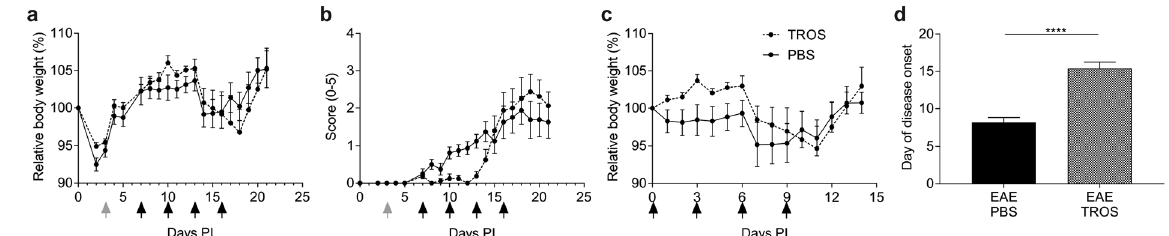
Figure 7. ( a – d ) Local therapeutic treatment with TROS delays EAE development but does not prevent it. hTNFR1 transgenic (Tg) mice were immunized with MOG 35-55 peptide and pertussis toxin to induce EAE. Three days post-immunization (PI), brain cannulas were implanted (grey arrow). When 6/16 of the mice were symptomatic (7 days PI), they were divided in balanced groups. 7.75 µ g/5 µ l TROS (n = 8) or 5 µ l PBS (n = 7) was directly infused through a cannula into the brain ventricles every three days until day 16 PI (black arrow). Mice were weighed and clinically scored daily. (a , b ) Relative body weight (relative to initial body weight) ( a ) and clinical scores (scale 0-5) ( b ) were assessed in all mice. Black arrows indicate the days of treatment. Body weight and clinical symptoms were monitored for 21 days. ( c ) Changes in relative body weight compared to body weight at the start of the treatment (7 days PI) in TROS and PBS treated mice. (d ) Day of disease onset, defined as the day of being symptomatic for two consecutive days, in hTNFR1 Tg mice treated with TROS or PBS. Data information: Graphs and bars represent mean ± SEM. Clinical scores were analyzed as repeated measurements using the restricted maximum likelihood (REML) variance components analysis. Data were analyzed with an unpaired t test. * 0.01 ≤ p < 0.05; ** 0.001 ≤ p < 0.01; *** 0.001 ≤ p 0.0001, **** p < 0.0001. Non-statistically significant differences are not indicated on the